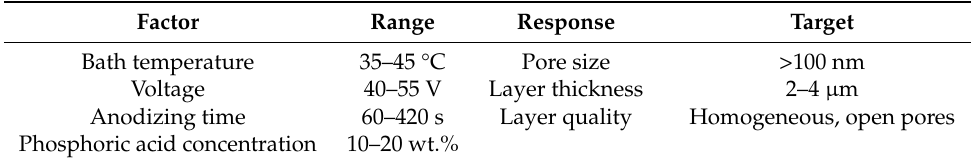
Table 1. Design of